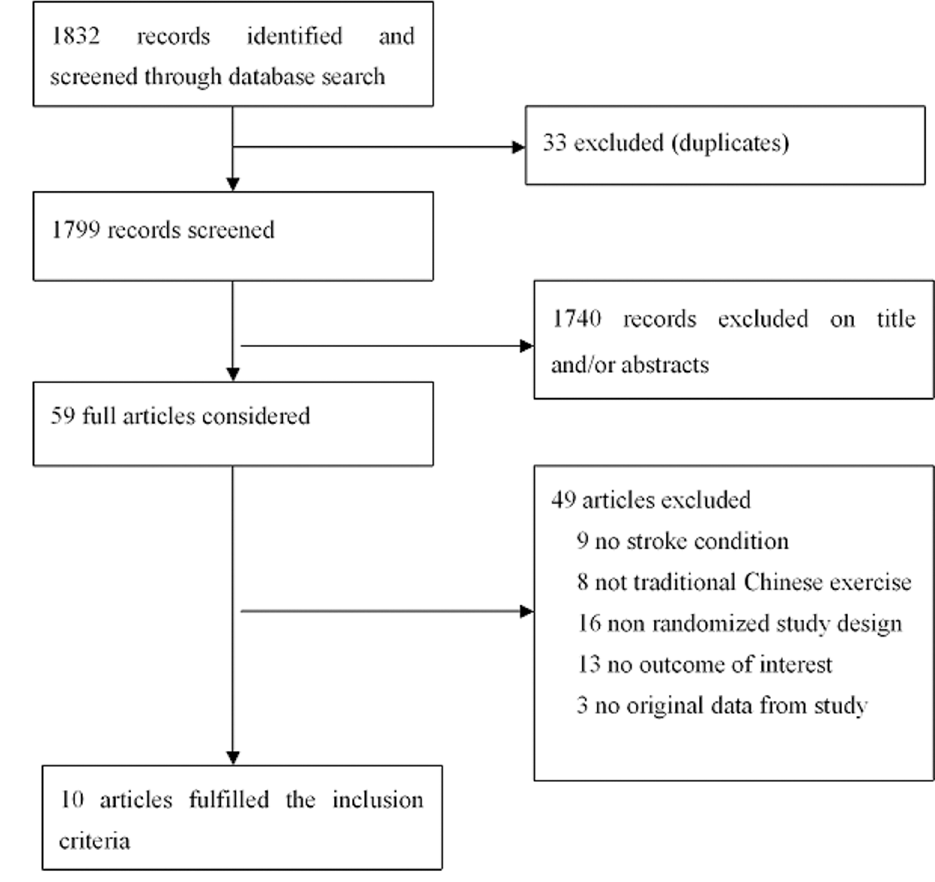
Fig 1. Flow chart of the study selection procedure. For details of study